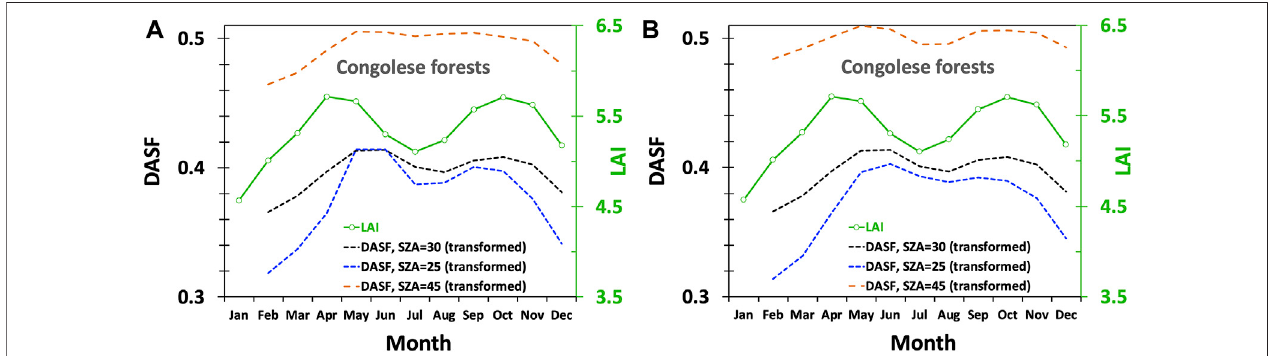
FIGURE 14 | Annual courses of LAI and transformed EPIC DASF at SZA (cid:2) 25 0 , 30 0 and 45 0 with (A) varying and (B) fi xed phase angles. Monthly data were accumulated over the period 2015 to December 2018.